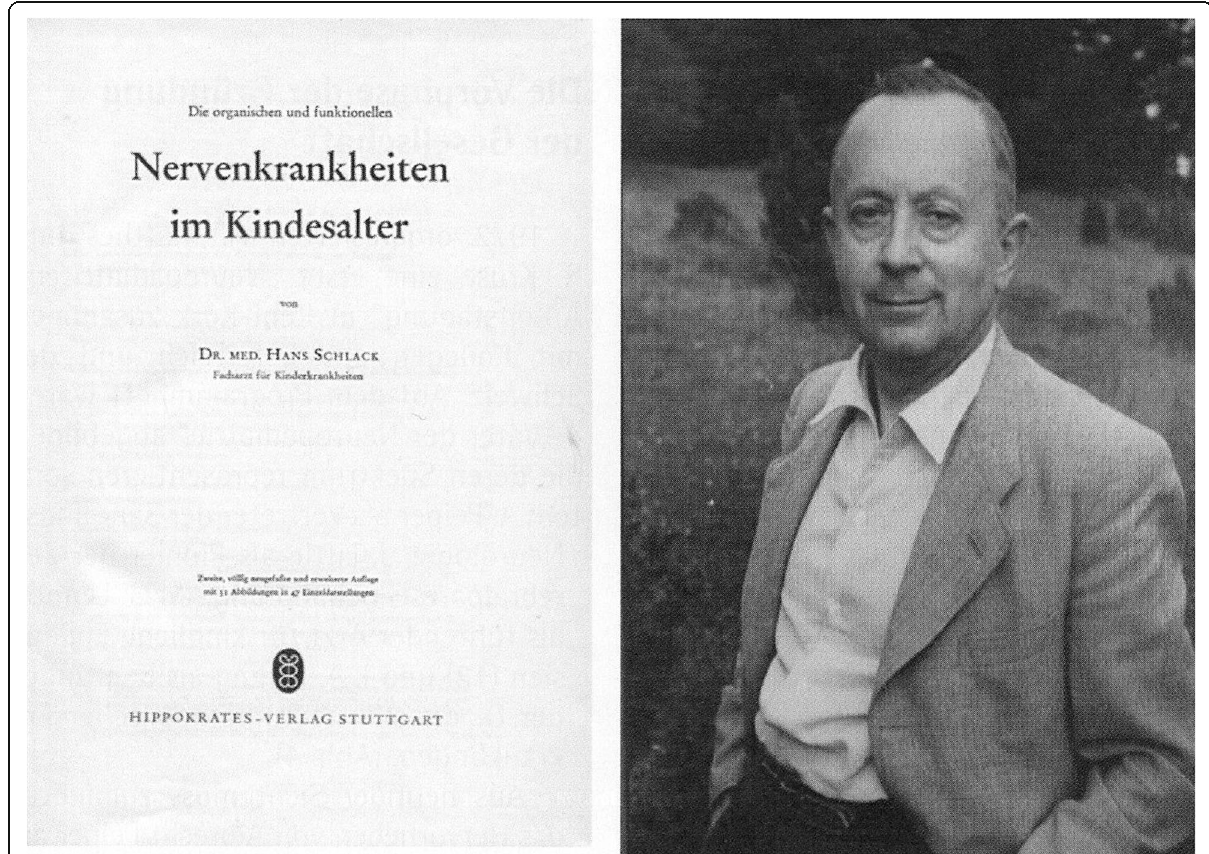
Fig. 1 a and b The first page of the monography „ Die organischen und funktionellen Nervenkrankheiten im Kindesalter ” by Hans Schlack (1898